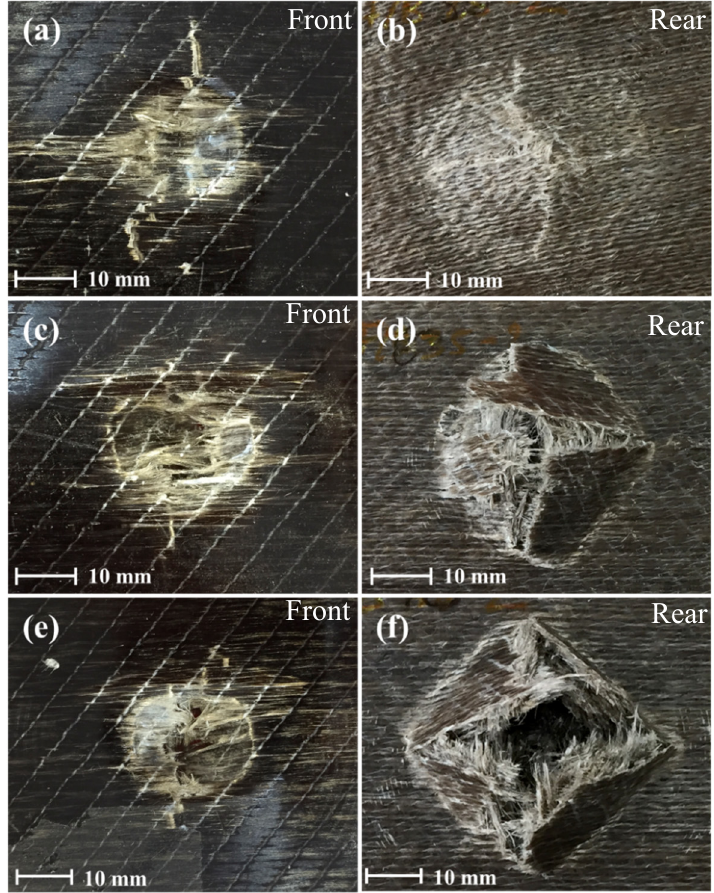
Figure 11. Images of damage progression on front and rear faces of flax / VE / basalt hybrid composite panels impacted in the range of ( a and b ) 50 J, ( c and d ) 60 J, and ( e and f ) 70 J.